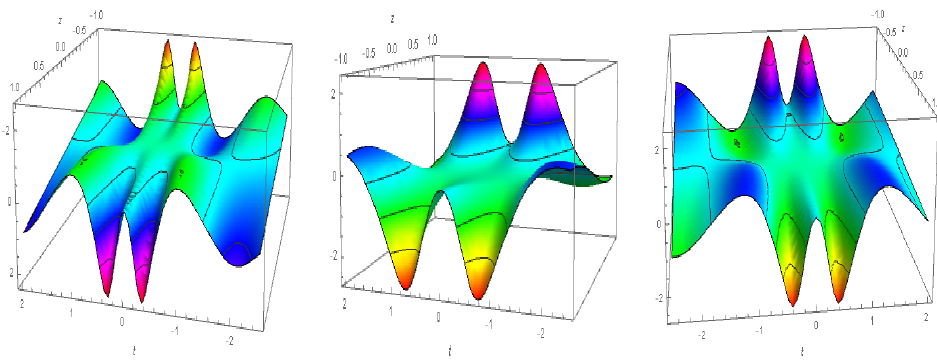
Figure 13. The AB profiles of the solution ∆ 7 in Equation (27) are made through values of a = 5, b = 1, c = 3, p 0 = 4 and m = 5. Three-dimensional graphs at (i) β = 5, (ii) β = 10 and (iii) β = −